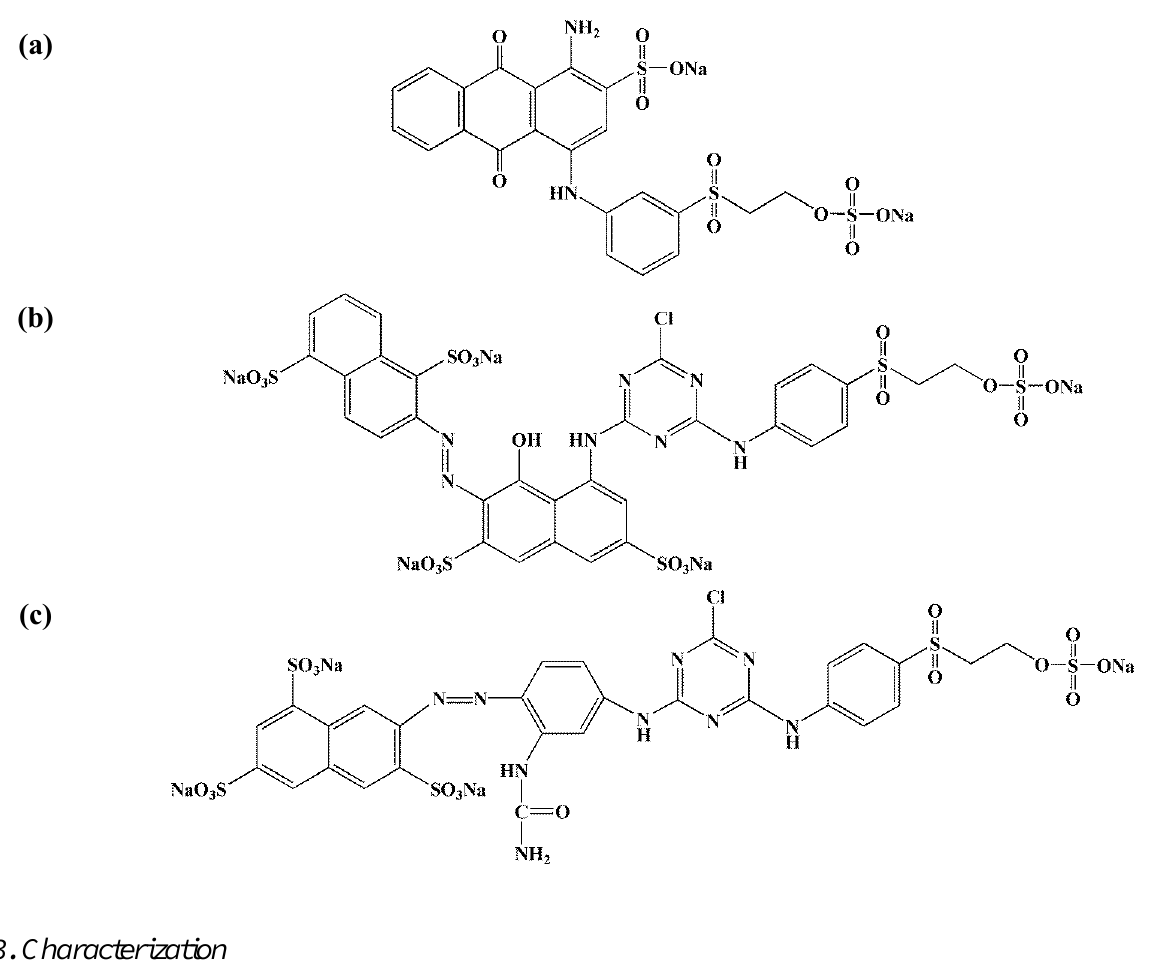
Figure 1. Chemical structures of reactive dyes used: ( a ) Remazol Brillant Blue RN